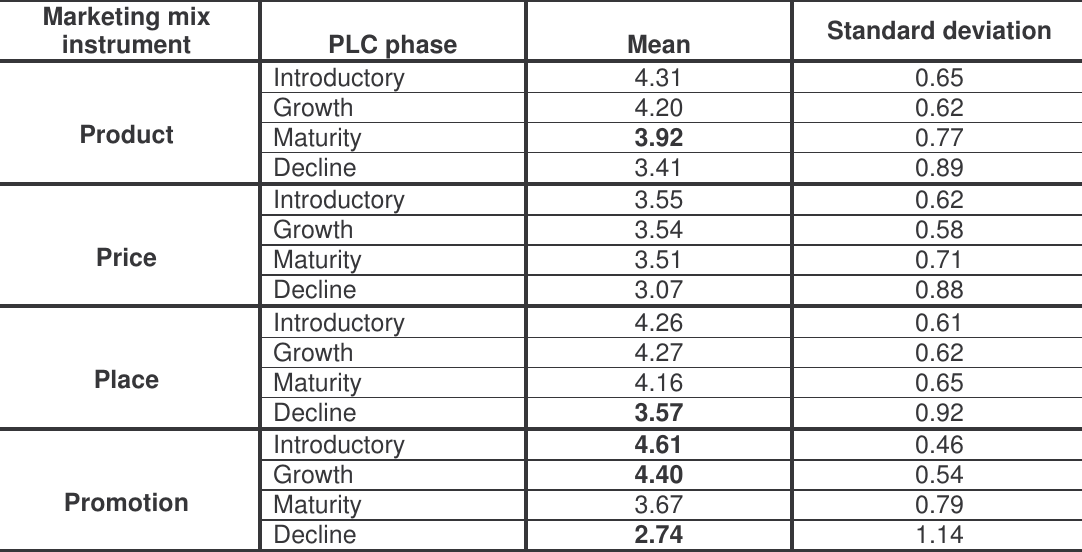
The importance of the marketing mix instruments in the different